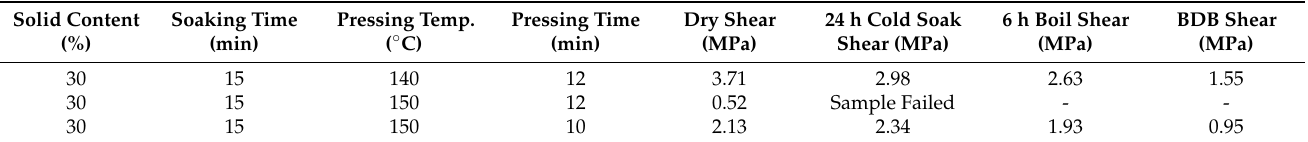
Table 3. Shear strength of MGE plywood produced using different solid content, soaking time, pressing temperature, and time.